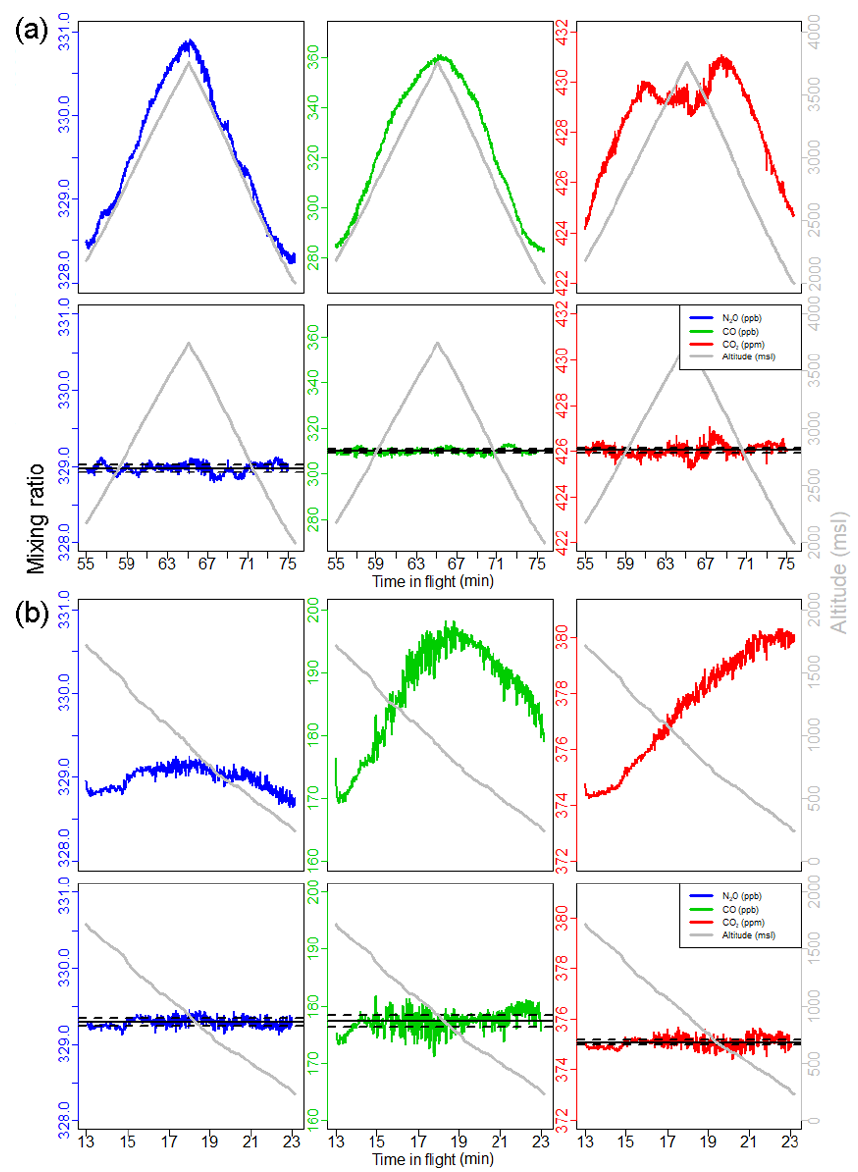
Figure 7. Panel (a) shows FCHAOS data from a null test on 26 April 2017, and panel (b) shows data from a null test on 2 May 2017, the same seen in Fig. 4. Rows 1 and 3 show N 2 O, CO, and CO 2 during the null test before any calibration, and rows 2 and 4 show the gas data following the frequent calibration correction. The procedure removes cabin pressure dependence and calibrates for linear drift. Black horizontal lines show mean and 1 σ